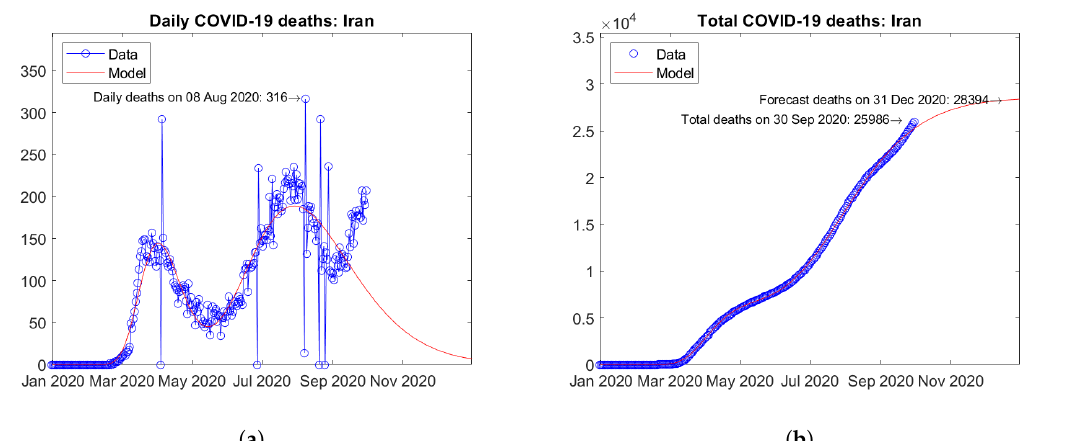
Figure 6. Actual and predicted trends in Iran: ( a ) daily deaths, ( b ) total deaths.